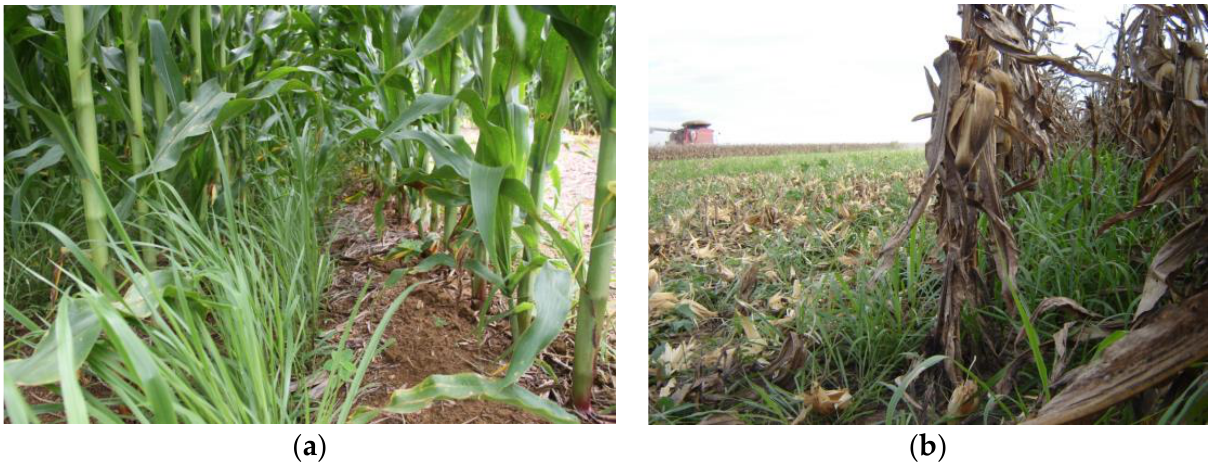
Figure 13. ( a ) Combined use of corn and Urochloa brizantha in a crop – livestock mixed system. ( b) Corn being harvested and the grass left for subsequent grazing (Photos courtesy of Dr. Rodrigo Almeida).